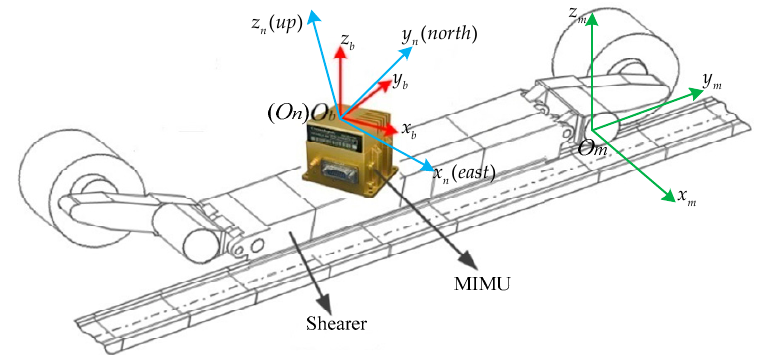
Figure 2. S chematic diagram of the coordinate systems. Figure 2. Schematic diagram of the coordinate